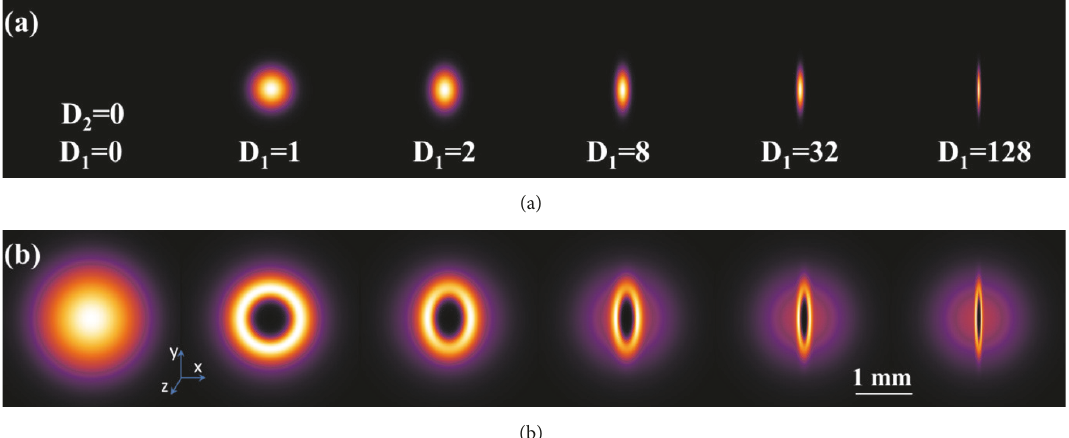
Figure 3: (a) Spatial distribution of control beams with D 2 =1, D 1 =1, 2, 8, 32, and 128. (b) Spatial intensity profile of signal laser beams under different control beams in Figure 3(a).